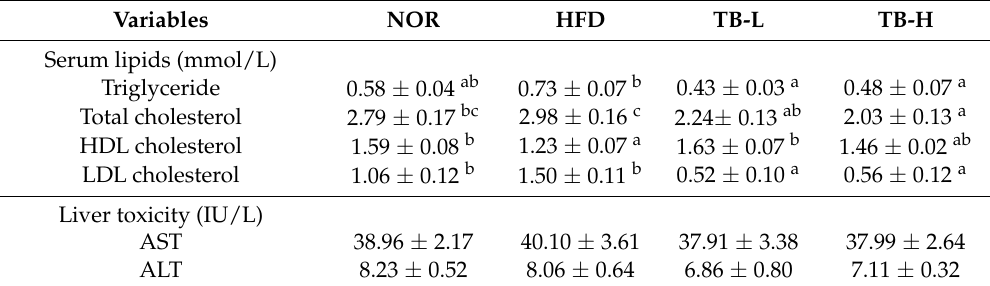
Table 4. Effect of tartary buckwheat extract on serum lipid